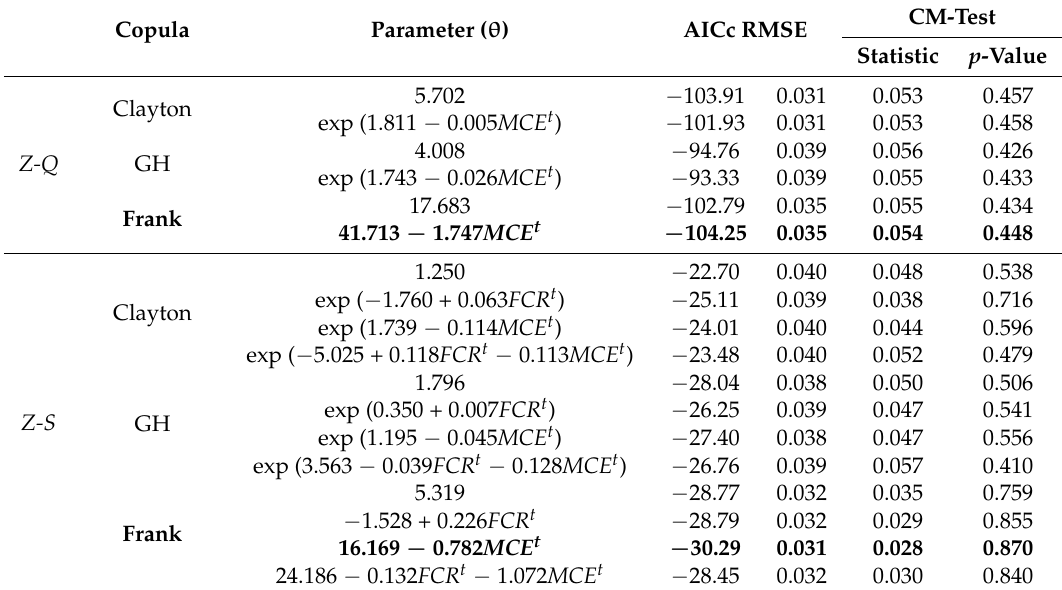
Table 4. Parameters and goodness-of-fit of the candidate bivariate copulas fitted to Z-Q and Z-S at the Waizhou station during 1964–2013,